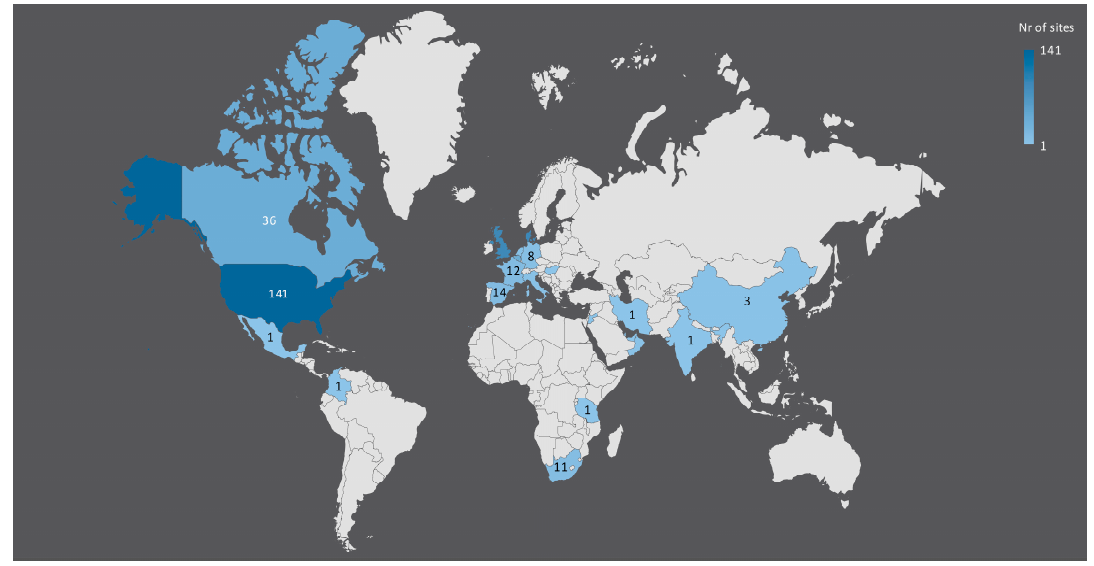
Figure 1. Worldwide distribution of aerated treatment wetland systems as of June 2019.